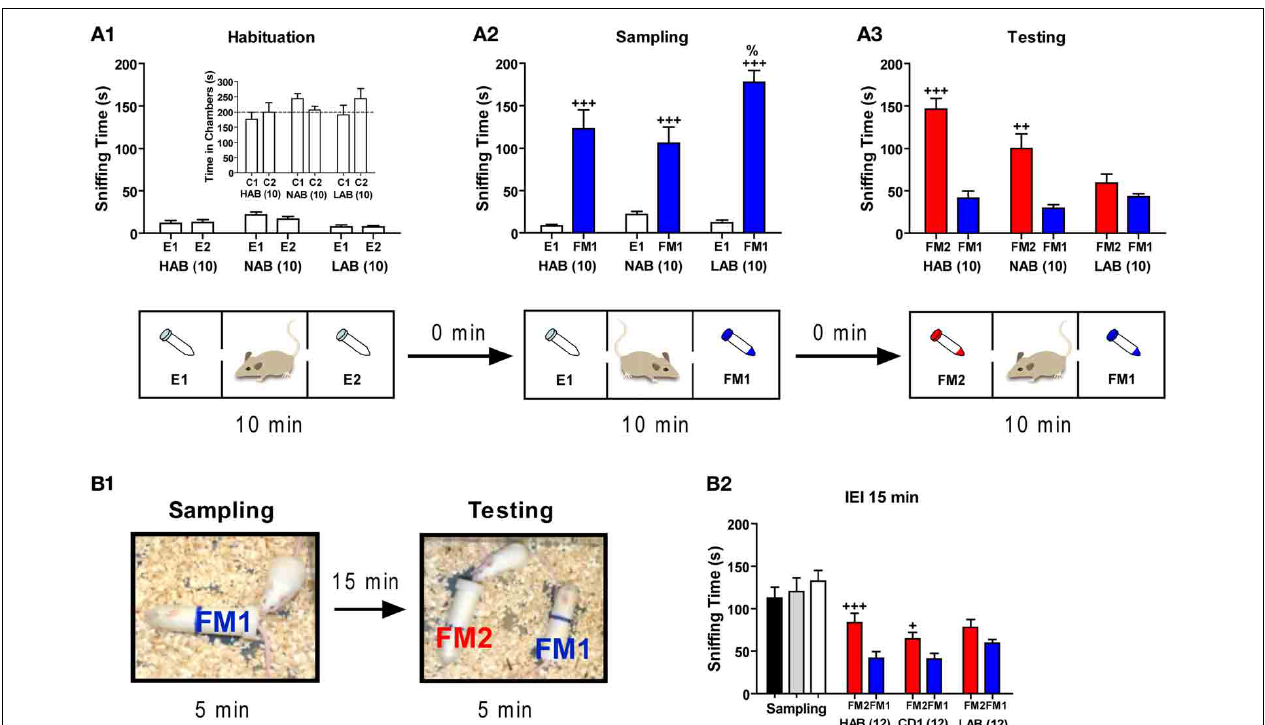
compared to the empty tube (E1). LAB mice apparently lost interest in social investigation during the testing phase (as mirrored by the reduced total sniffing time) and failed to show a preference for the novel female (FM2). (B1,B2) In a social discrimination task, all three lines were introduced to an ovariectomized female (FM1) in an experimental chamber for 5min, and after an interexposure interval (IEI) of 15min, they were exposed to the familiar female (FM1) and a novel ovariectomized female (FM2) for another 5min. Sniffing time did not differ between all three lines during the sampling phase. After 15min, both HAB and NAB could discriminate between the FM1 and FM2, whereas LAB mice failed to do so. +++ p < 0 . 001; ++ p < 0 . 01; + p < 0 . 05 compared with E1 or FM1 (paired t -test). % p < 0 . 05 compared with HAB/NAB (FM1) (unpaired t